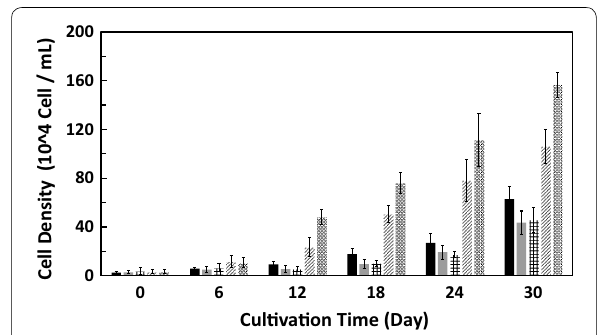
Fig. 1 Growth profile of Euglena gracilis with different concentrations of ferulic acid. N.C. negative control group. Symbols correspond to (Black square) control group, (black square) negative control group, (square with orthogonal crosshatch fill) 10 mg/L ferulic acid, (square with upper right to lower left fill) 100 mg/L ferulic acid, (square with diagonal crosshatch fill) 500 mg/L ferulic acid